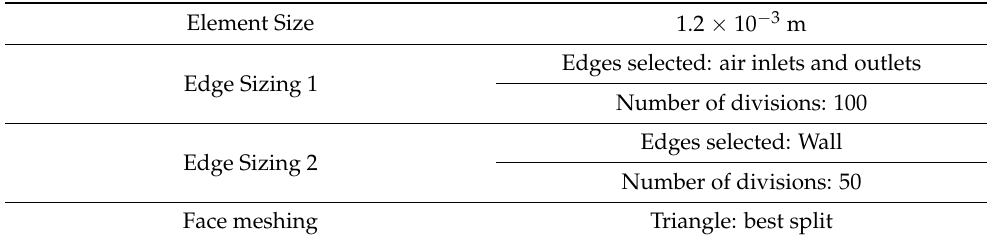
Table 1. Meshing properties of 2D model of atomisation chamber.